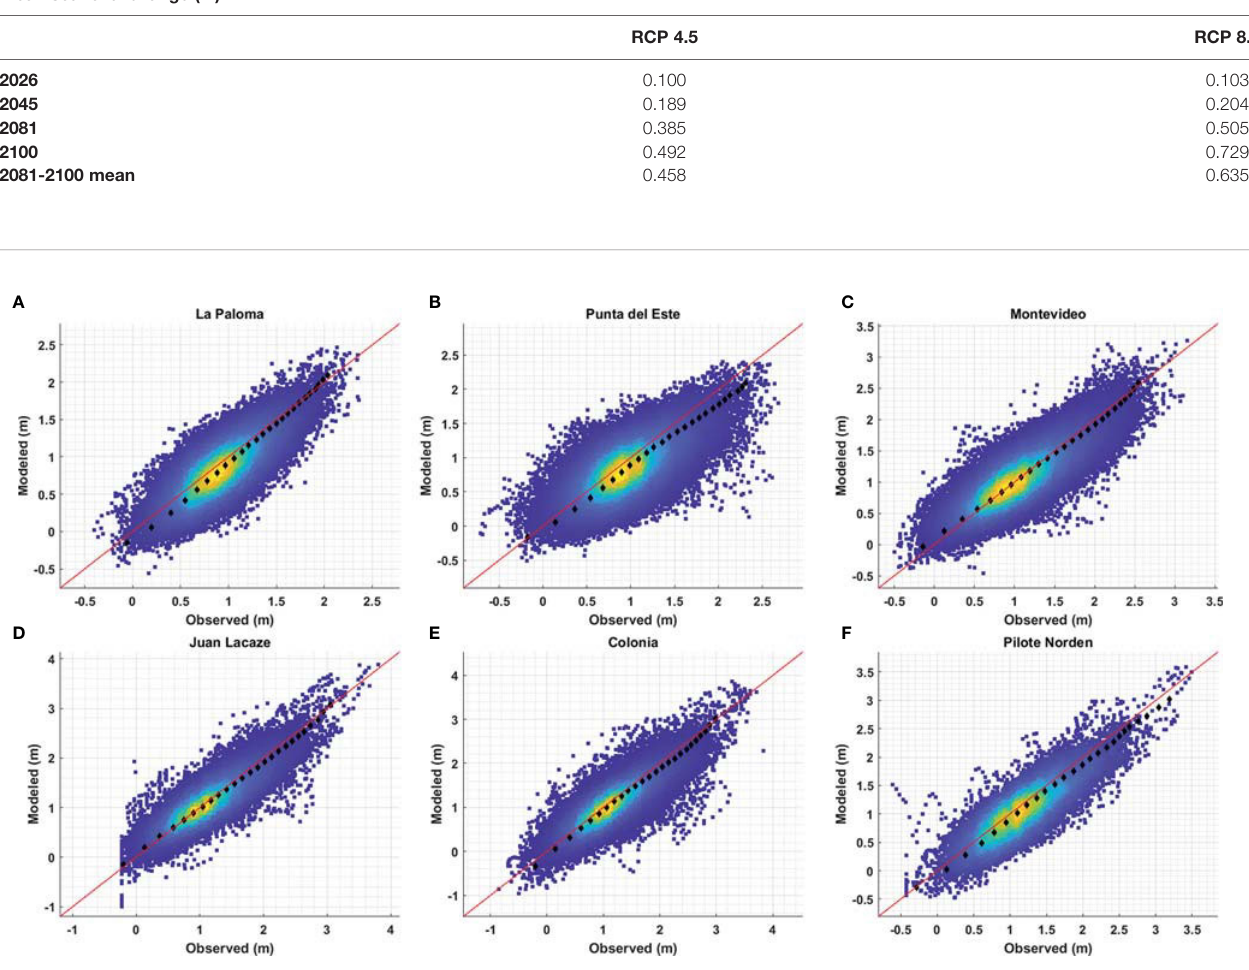
TABLE 4 | Mean sea level change used in this work for RCP 4.5 y RCP 8.5 scenarios. Mean sea level change